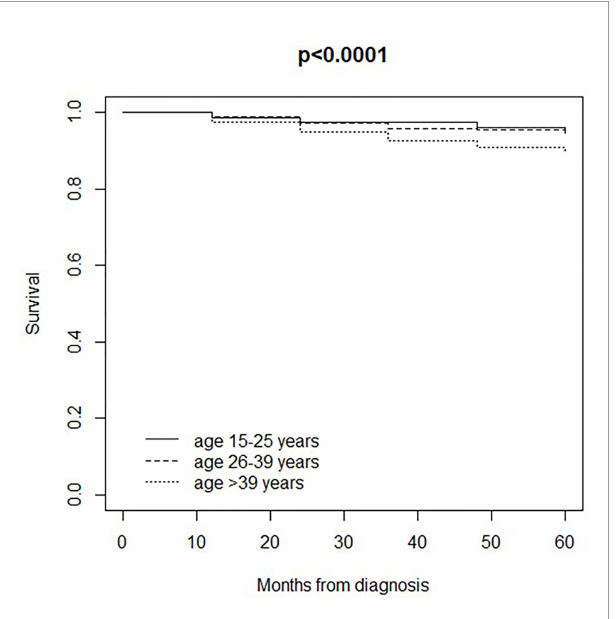
FIGURE 1 | Disease-speci fi c survival in 2,734 patients (18 patients were lost to follow-up) aged ≥ 15 years and living in the Veneto Region who were diagnosed and/or treated for Melanoma between 1998-2014 at the Veneto Institute of Oncology and at the University Hospital of Padua (Italy): comparison between age classes (15-25 years, 26-39 years, 40 years or older).